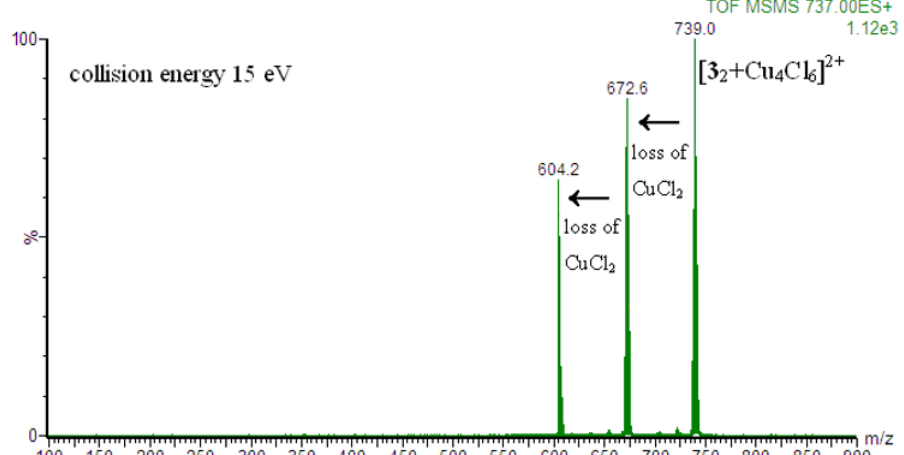
Figure 6. CID MS/MS spectrum of ion [3